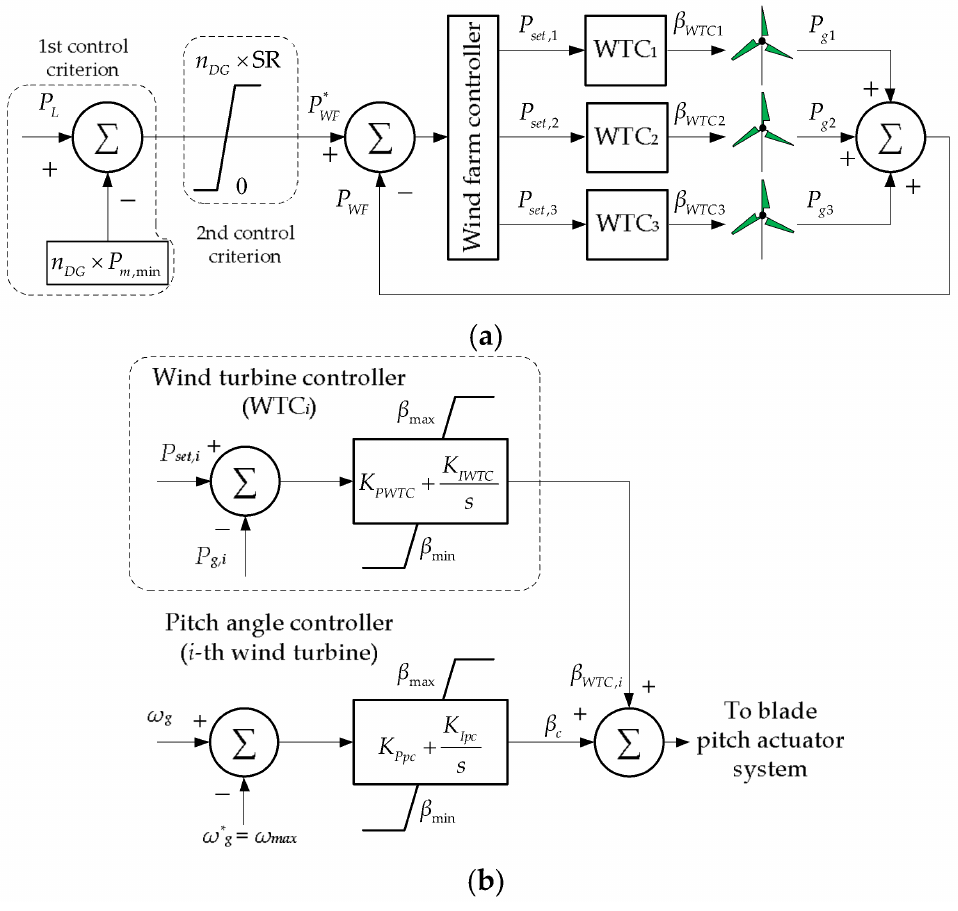
Figure 7. Wind farm controller structure: ( a ) General scheme; ( b ) Implementation of the